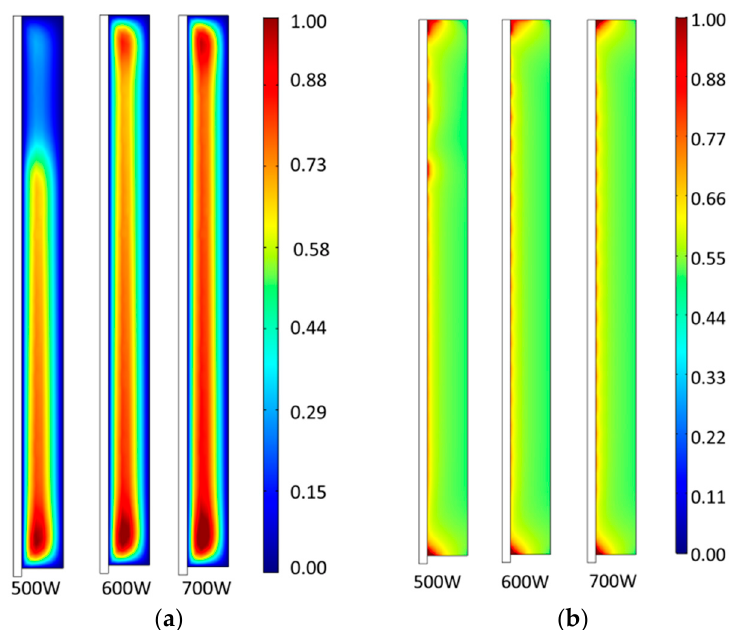
Figure 2. COMSOL simulation of the electron density and temperature distributions at a fixed pressure of 80 Pa under Port 1 2450 MHz microwave power: ( a ) electron density ( b ) electron temperature.